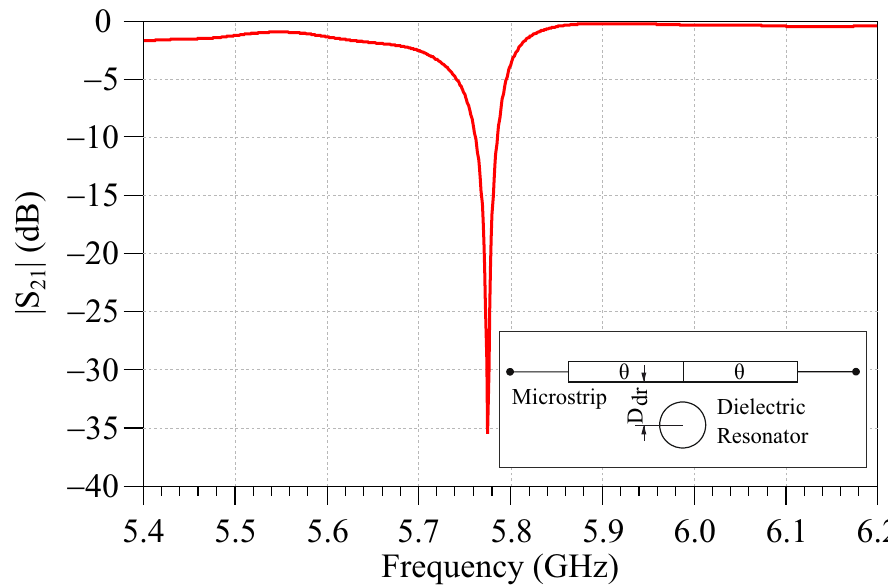
Figure 2. Measured response of the subsections composing the DR tuneable filter: DR resonator coupled with the microstrip line.